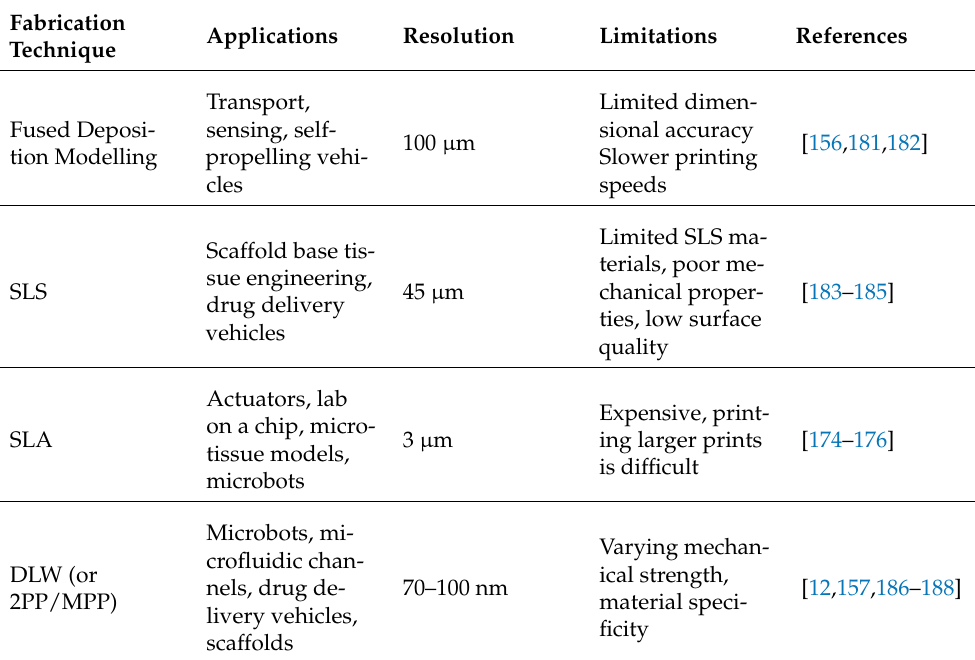
Table 2. Comparison between different fabrication